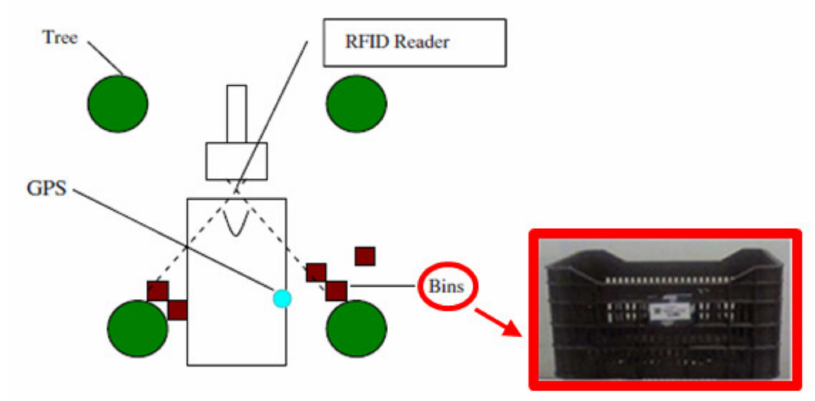
Figure 4. Representation of bins collection by the tractor equipped with a radio frequency identification (RFID) reader and di ff erential GPS (DGPS)